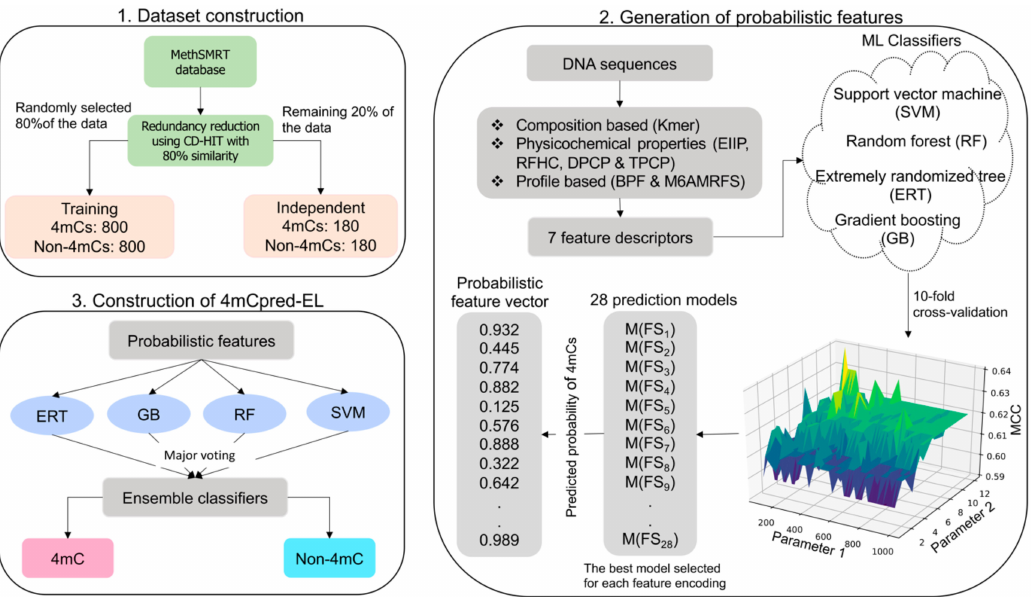
Figure 1. Schematic framework of 4mCpred-EL. It involves the following steps: ( 1 ) Dataset construction for the mouse genome, ( 2 ) Generation of probabilistic features using varied ML classifiers and seven feature encodings, and ( 3 ) Final model construction that discriminates the input into 4mC or